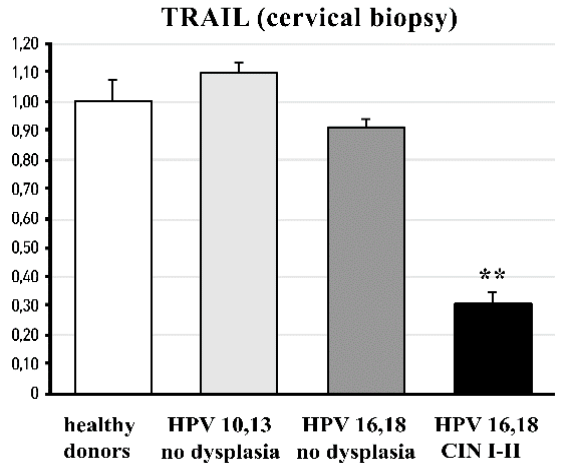
Figure 4. sFAS and TRAIL mRNA expression (arbitrary units) in cervical biopsies of females with HPV infection and of healthy donors. Sample size of groups: HPV 10/13, n = 42; HPV 16/18 and healthy, n = 152; HPV 16/18 CIN I and CIN II, n = 75; healthy donors, n = 15. * p < 0.05 ** p < 0.01 vs. healthy donors, and low and highly oncogenic HPV infection.